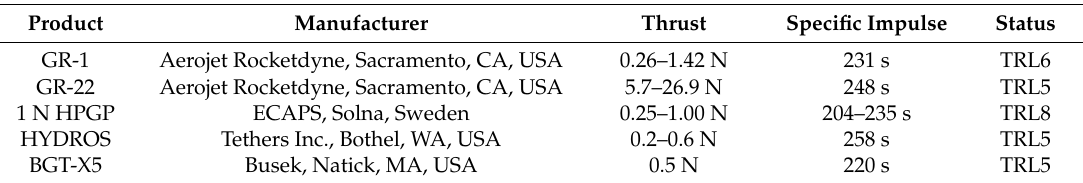
Table 8. Green Propellant Propulsion Systems (NASA, 2015)